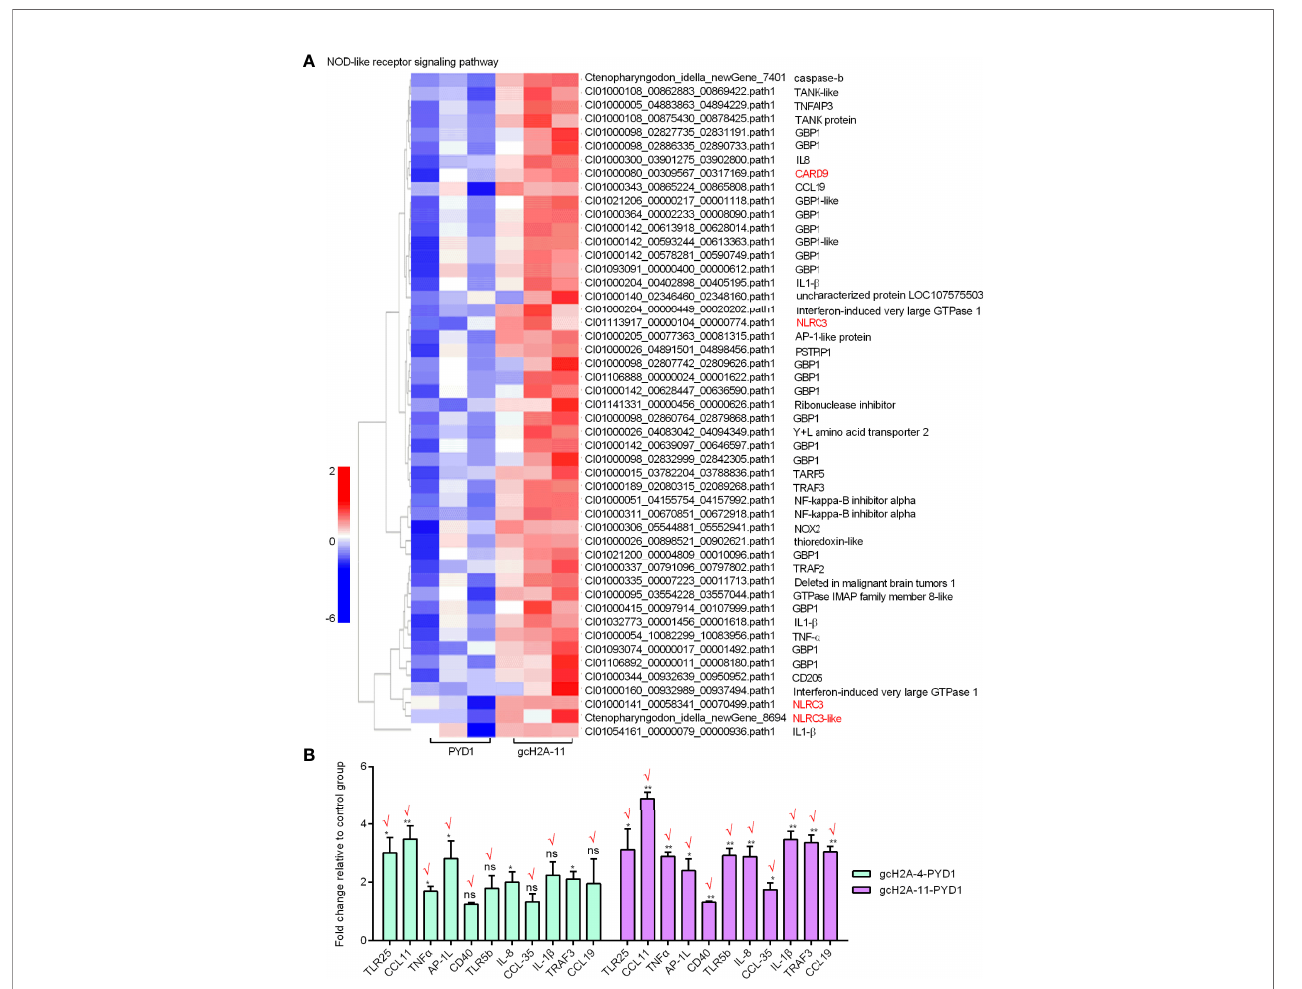
FIGURE 7 | Validation of transcriptome data by qRT-PCR. (A) The gene cluster for DEGs involved in the NOD-like receptor signaling pathway for the samples from the intestines of grass carp after 7 days of the fi rst immunization using the engineered S. cerevisiae expressing gcH2A-11. (B) Validation of transcriptome data by qRT-PCR for 11 DEGs involved in the Toll like receptor pathway. Data represented means ± SEM (n=3), and were tested for statistical signi fi cance. * p < 0.05; ** p < 0.01; ns, not signi fi